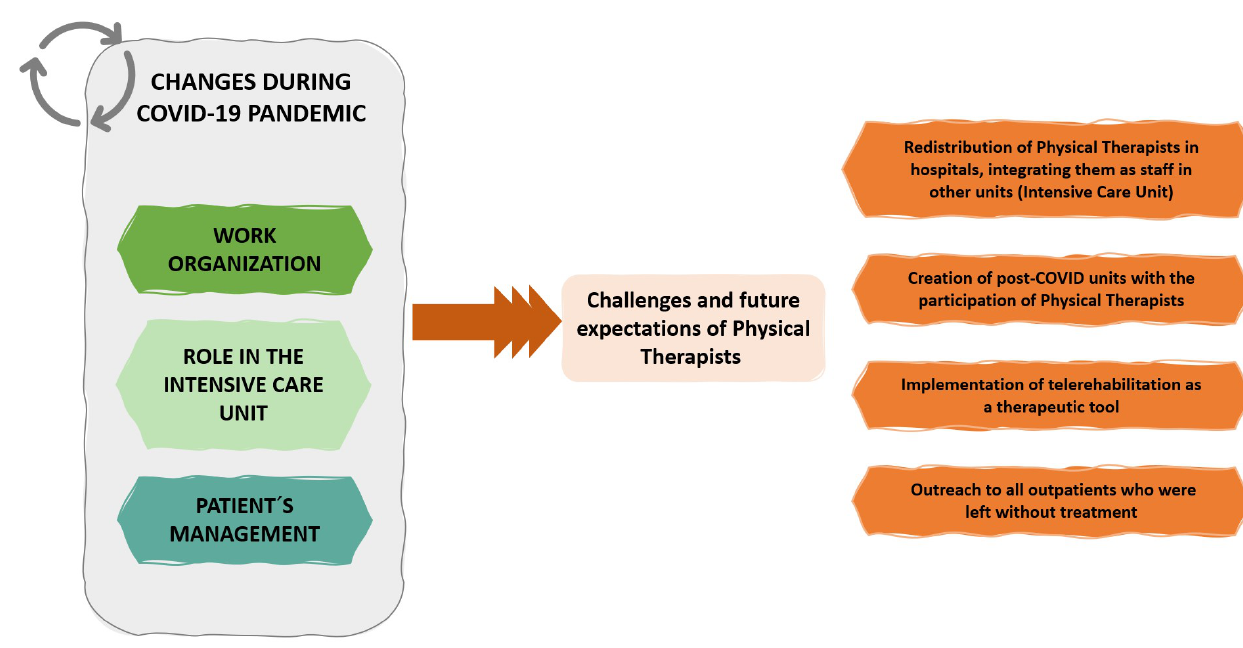
Figure 1. Schematic representations about the changes experienced during the pandemic and changes described as potential new challenges for the physical therapy profession in the